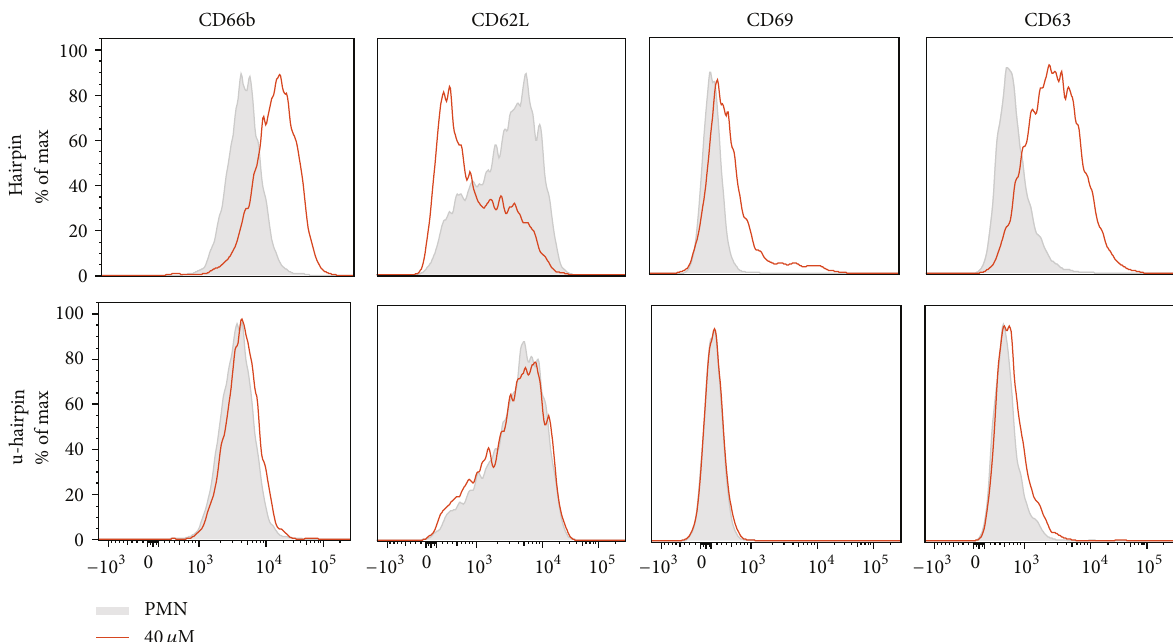
Figure 2: The hairpin structure of CAAP48 is responsible for the function of the peptide. For identification of the functional domain of the peptide, we incubated fresh isolated PMN with the hairpin peptide and the sequence until the hairpin (u-hairpin) for 30 min. Cells were analyzed for surface expression of CD66b, CD63, CD69, and CD62L by flow cytometry. The hairpin peptide activates PMN, while the u- hairpin peptide shows no activation. Differential expression of activation markers is shown in histograms of one representative experiment out of four independent experiments using peptide concentrations of 40 𝜇